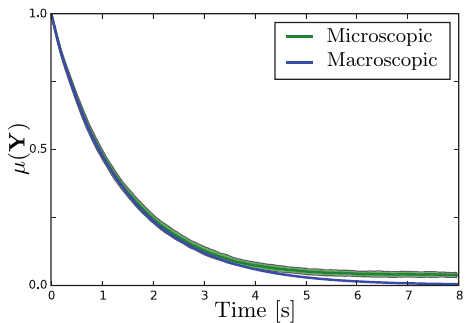
Figure 3: Ratio of misplaced traits over time for the initial and desired trait distributions depicted in Fig. 1. The simulation was run with 800 robots. The plot shows the macroscopic model as well as the average over 100 iterations of the microscopic model. The shaded area shows the standard deviation.